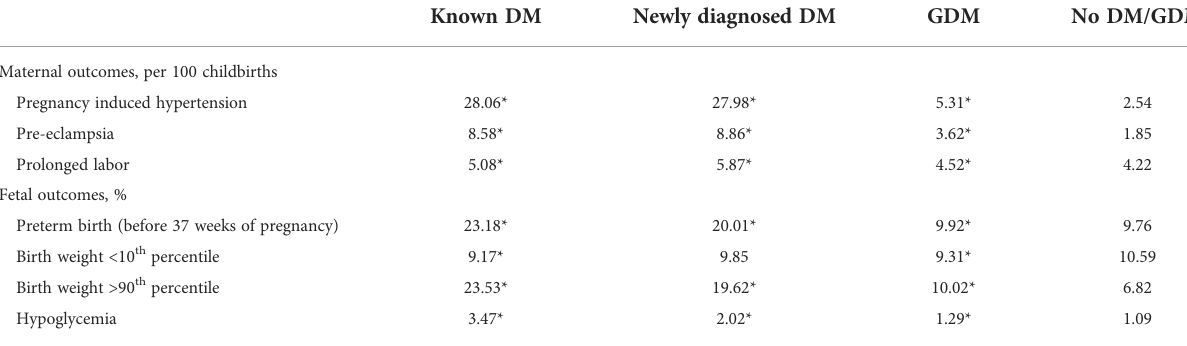
TABLE 4 Maternal and fetal outcomes by diagnosis of diabetes, 2008-2017.